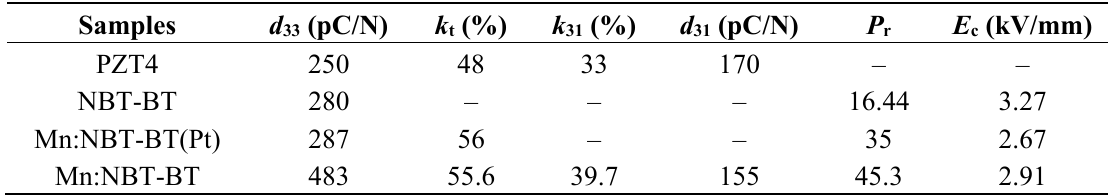
Figure 16. (Color online) ( a ) P - E hysteresis loops for Mn:NBT-BT samples compared with Mn:NBT-BT one; ( b ) strain vs . bipolar electric field curve for Mn:NBT-BT crystals at room temperatures. Reprinted with permission from [29]. Copyright 2009 AIP Publishing LLC. Table 3. Piezoelectric and ferroelectric properties of PZT4 ceramics and NBT-BT, Mn:NBT-BT, and Mn:NBT-BT single crystals. Reprinted with permission from [29]. Copyright 2009 AIP Publishing